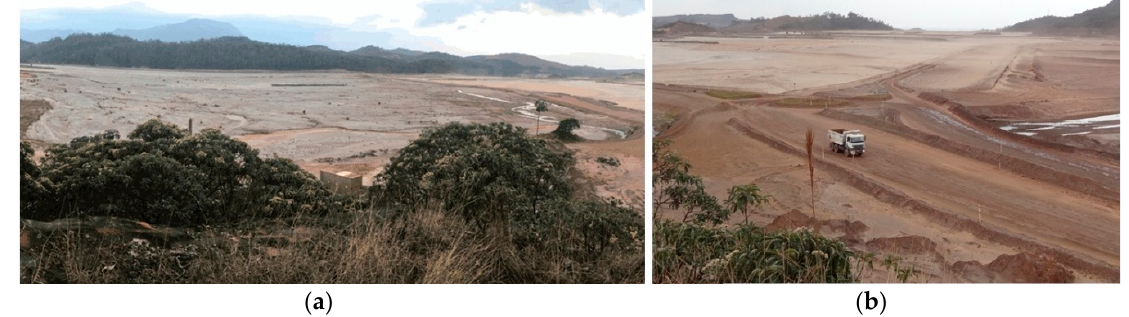
Figure 19. Field picture of the Baía 3 dam and its reservoir ( a ) and the auxiliary dike that cross the Germano reservoir ( b ).